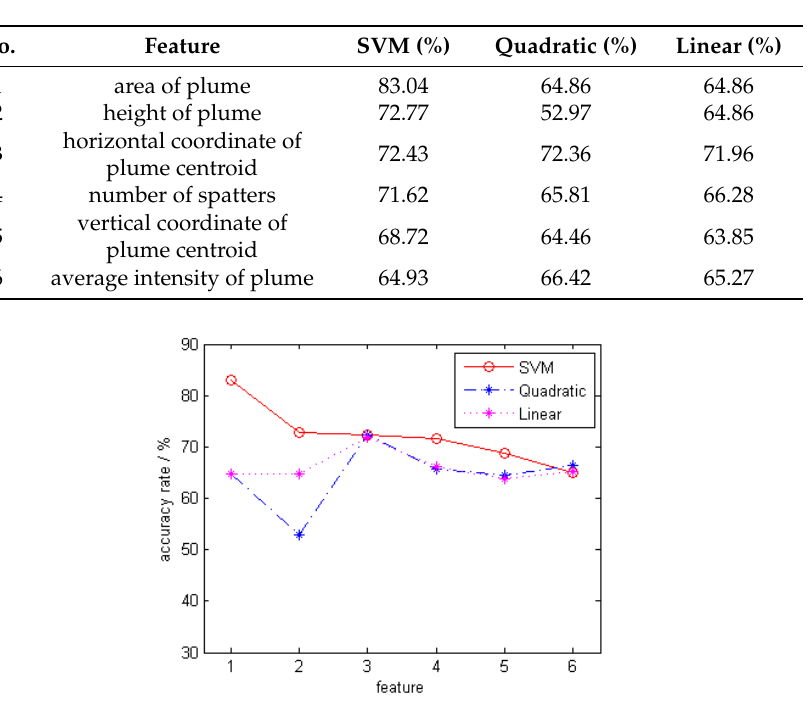
Table 3. The classification results of SVM, quadratic discriminant analysis, and linear discriminant analysis.